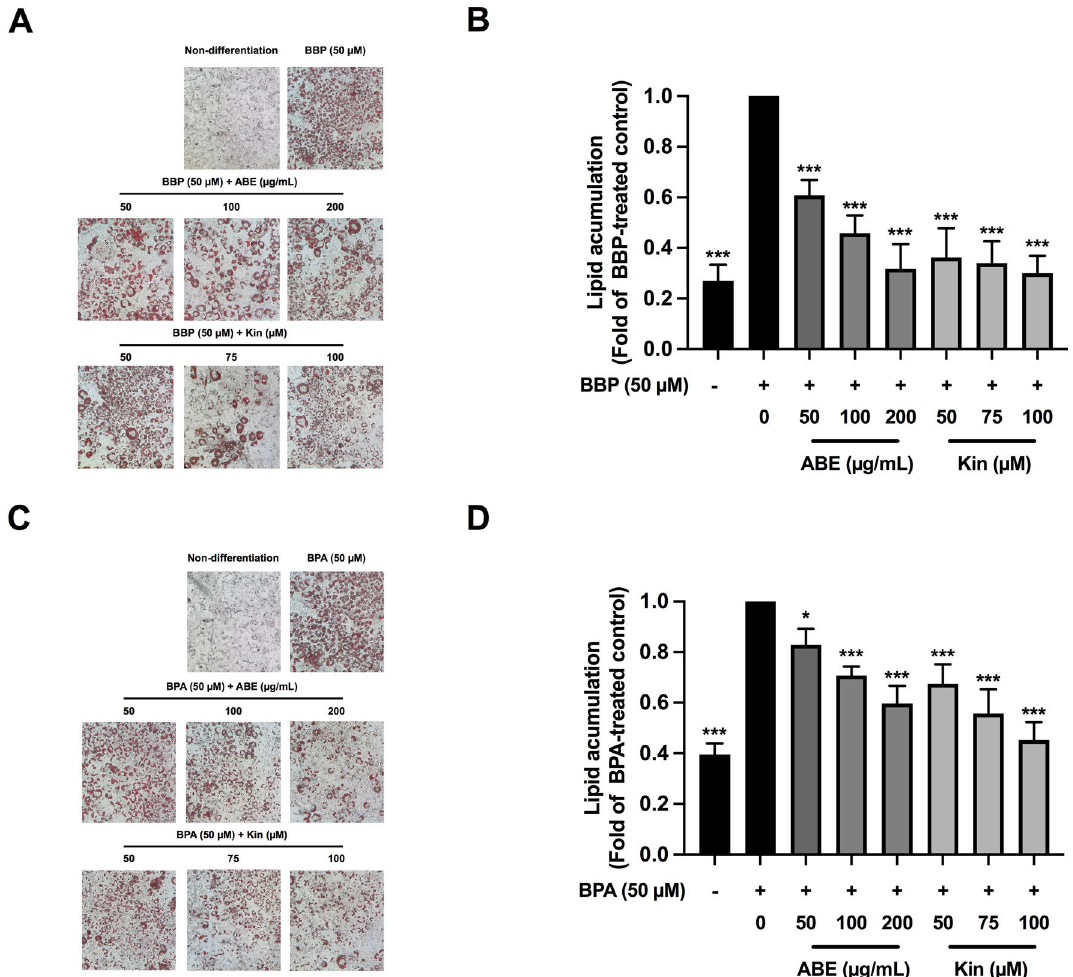
Figure 2. The effect of ABE or Kin on obesogen-induced lipid accumulation in 3T3-L1 cells determined by Oil-red-O staining assay. Intracellular lipid droplet ( A ), and the level of lipid accumulation ( B ) of ABE- or Kin- treated cells in the presence of BBP (50 µM). Intracellular lipid droplet ( C ), and the level of lipid accumulation ( D ) of ABE- or Kin-treated cells in the presence of BPA (50 µM). The data indicated as mean ± SD of three independent experiments * p < 0.05 and *** p < 0.001, compared to obesogen-treated